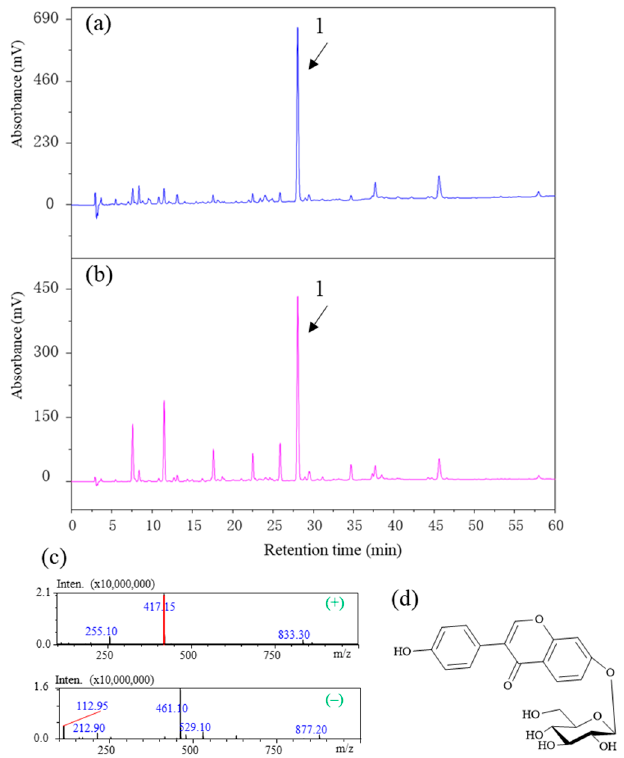
Figure 4. Representative chromatograms of DCM-PLS ( a ) purified and ( b ) unpurified by activated carbon measured at 254 nm. ( c ) MS spectra of peak 1 (daidzin) at positive and negative mode. ( d ) Chemical structure of daidzin. Peak 1: daidzin.